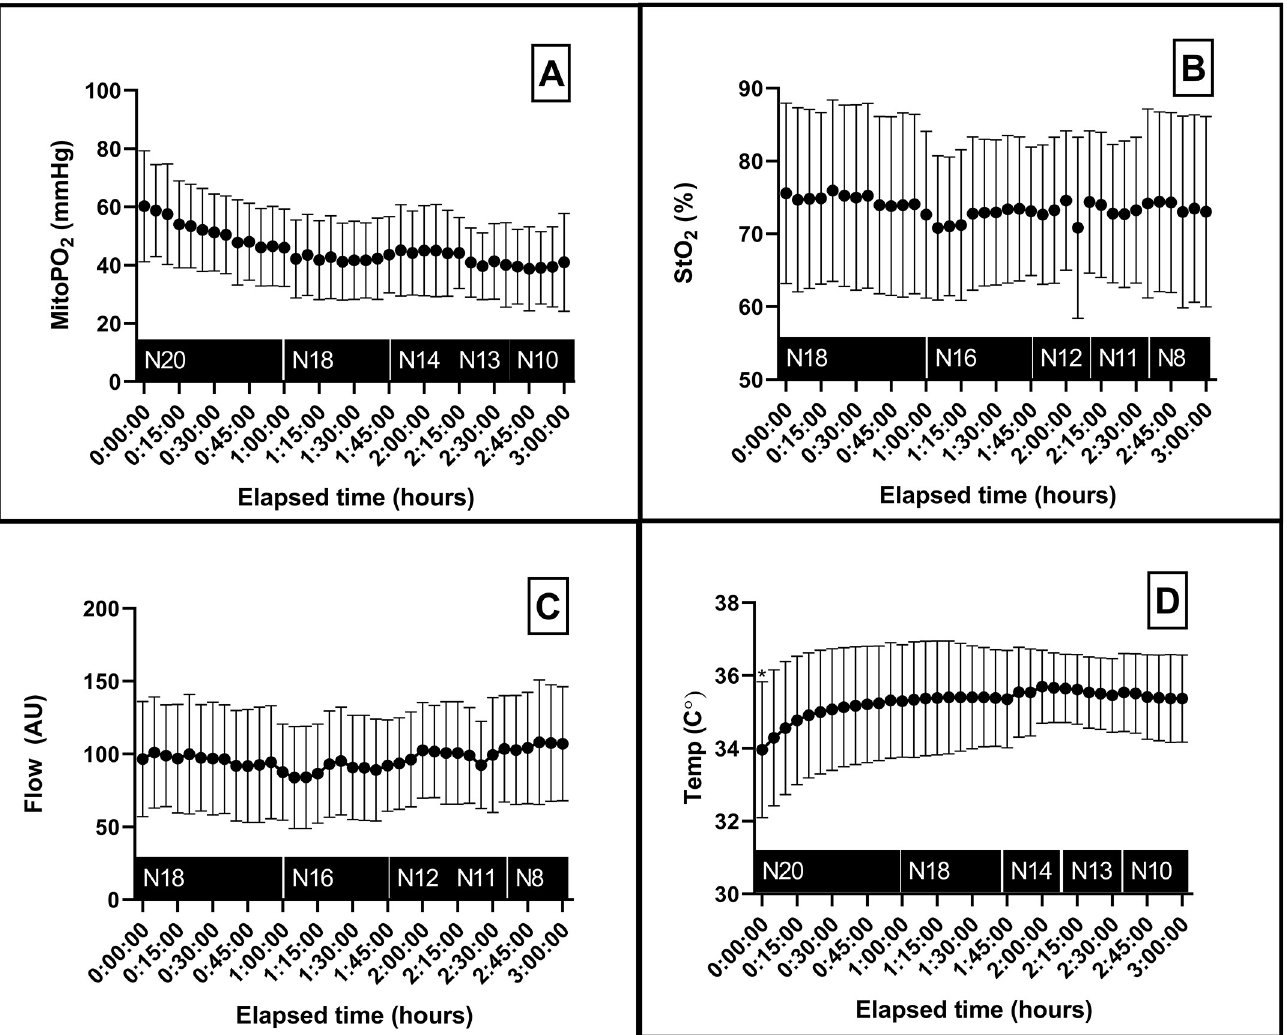
Fig 3. Overview of the microcirculatory parameters of the included patients during neurosurgery. A. Mitochondrial oxygen tension as measured by the COMET. B. Local capillary venous saturation as measured by the O2C. C. Mean flow in microcirculation measured with the O2C. D. Mean skin temperature. Data presented as mean (dot) and ± standard deviation. N; number of patients, MitoPO 2 ; mitochondrial oxygen tension, AU; arbitrary units, Temp; skin